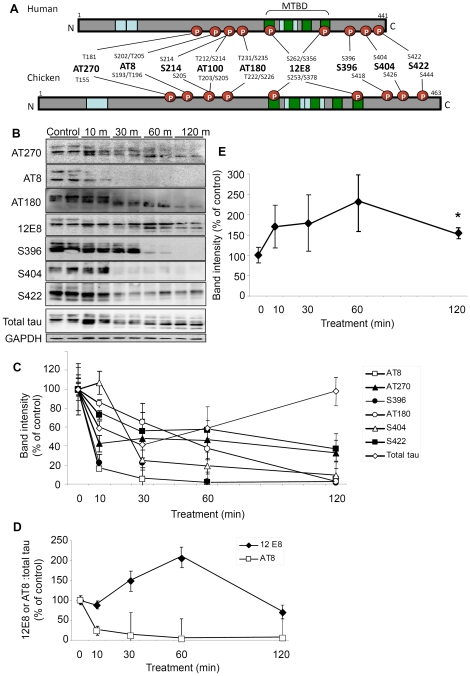
ATP reduction causes persistent phosphorylation of 12E8 epitope and dephosphorylation at other sites.(A) Epitope map of tau antibodies in human and chicken brain [38]. Schematic representations of the longest tau isoforms are shown (441 amino acid residues in human tau, 463 in chicken). The phosphorylation-dependent anti-tau antibodies (AT270, AT8, S214, AT100, AT180, 12E8, S396 S404 and S422) are shown with their corresponding target residues (S = Serine, T = Threonine). Positions of the various alternatively spliced inserts which give rise to 6 different isoforms in humans and 5 in chick are shown in blue. Green boxes denote tandem amino acid sequence repeats, which constitute the MTBD. (B) Representative Western blots of extracts from cell cultures treated in duplicate with 1 µM AM for 10, 30, 60 or 120 min. (C) Quantification of the Western blots shown in (B) reveal rapid dephosphorylation of AT8, S396 and AT270 epitopes (respectively declining to 16±0.03%, 23±9% and 43±9% of control values; mean %±min/max intensities). By 30 min, phosphorylation at epitope S404 had also markedly declined (25±11%) while epitopes S422 and AT180 exhibited a more moderate decline in phosphorylation (reduced to 55±3% and 65±20% at 30 min). Total tau was observed to decrease transiently (41±5% at 30 min) before returning to control levels (98±19%) at 120 min. All antibodies were probed on fresh blots and normalized to GAPDH loading control bands. (D) By contrast, phosphorylation of the 12E8 epitope increased markedly. To ascertain a phosphorylation∶total tau ratio, blots probed for 12E8 or AT8 (for comparison) were stripped and reprobed for total tau (polyclonal rabbit antibody). Whereas the AT8∶total tau ratio decreased rapidly, the 12E8∶total tau ratio increased at 30 min and peaked at ∼200% after 60 min. Error bars in (C and D) indicate the maximum and minimum intensities. (E) Quantification of persistent phosphorylation at the 12E8 epitope (normalized to GAPDH) was significant with a peak of >200% at 60 min and sustained phosphorylation (∼150%) at 120 min (n = 4; *p<0.05). Error bars = SEM.